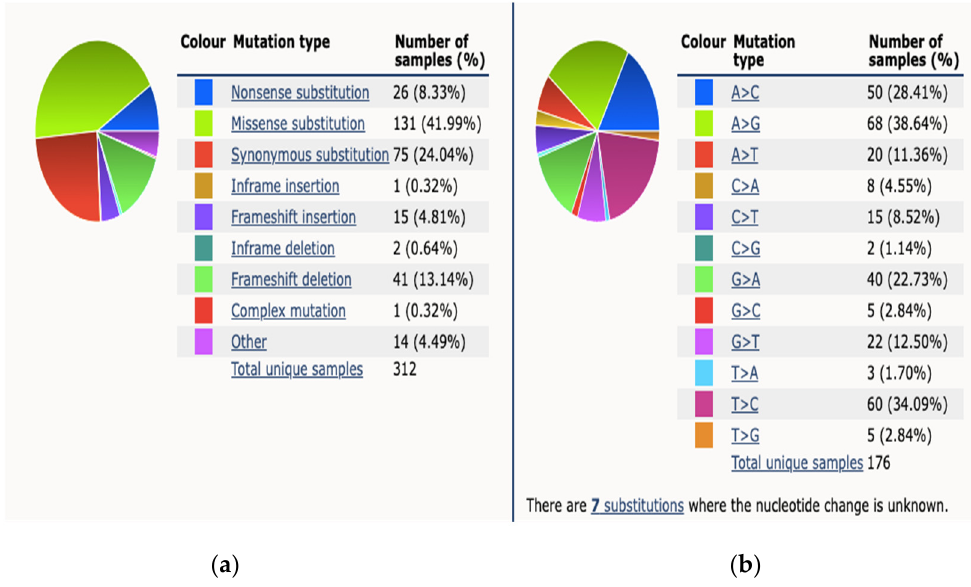
Figure 1. This figure demonstrates mutation distribution for BRCA2 gene as extracted from COSMIC database 2021. ( a ) An overview of the types of mutations observed ( b ) a breakdown of the observed substitution